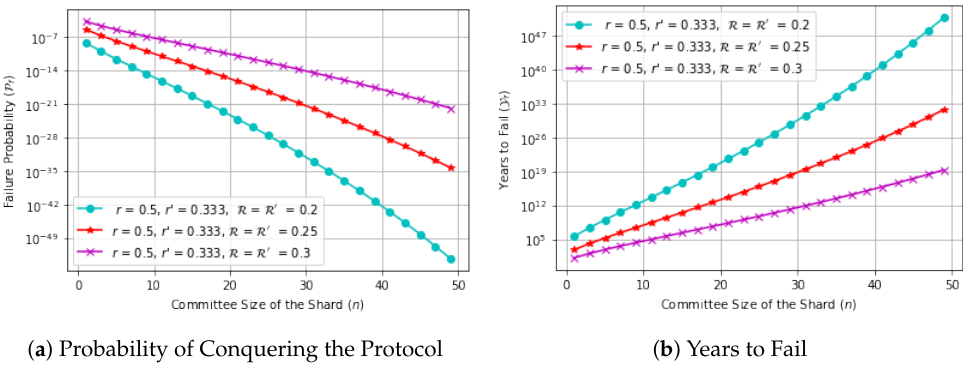
Figure 3. Log-scale plot: ( a ) Probability of conquering the protocol ( P f ) versus the committee size of the shard ( n ), ( b ) Number of years to fail ( Y f ) versus the committee size of the shard ( n ).